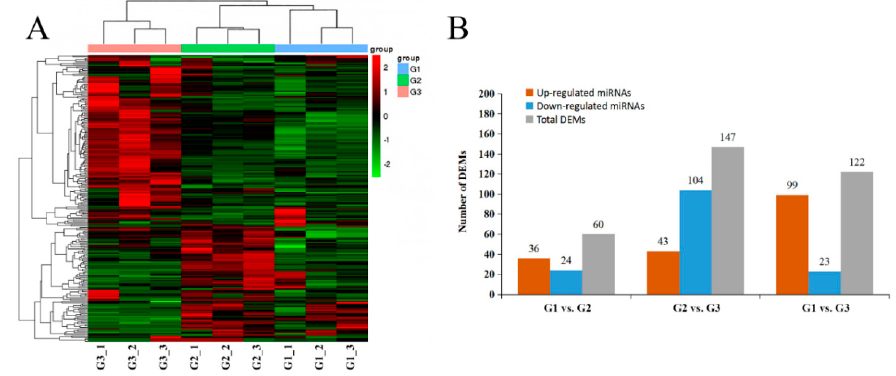
Figure 6. The expression profile of DEMs at di ff erent developmental stages of kernels. ( A ) Heatmap and clustering analysis of DEMs. ( B ) The number and characteristics of DEMs among di ff erent